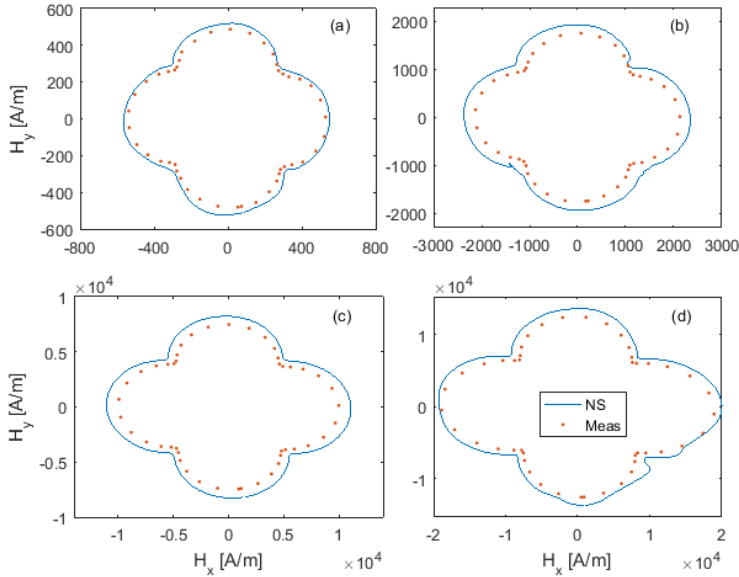
Figure 10. Family of rotational loops measured under two-tone magnetic induction waveforms (SET 3).